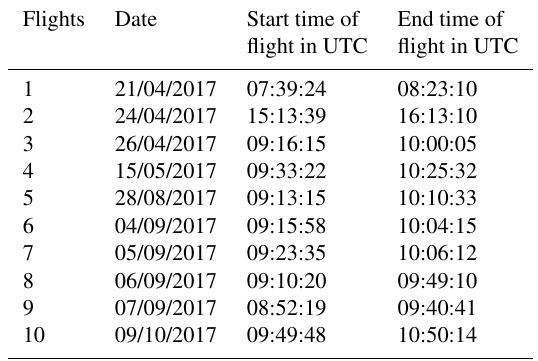
Table 4. AirCore flight performed during the FRM4GHG campaign in 2017 at the Sodankylä TCCON site. Date format: dd/mm/yyyy.